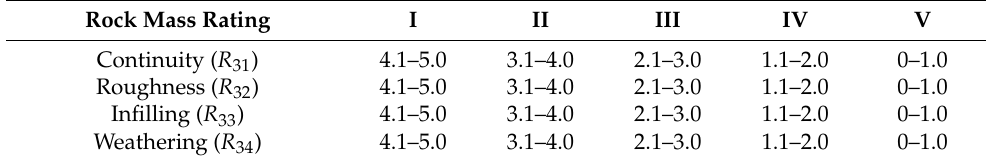
Table 2. Rating ranges of sub-indicators of R 3